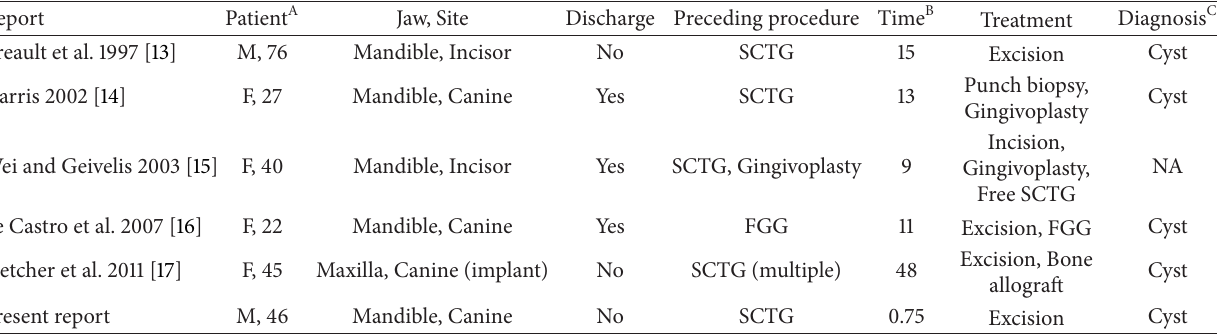
Figure 4: Routine histology of lesion: low-power (a) and higher power (b) photomicrographs. Note the stratified squamous nonkeratinized cystic epithelium lining the lesion and the surrounding subacutely inflamed fibrous connective tissue (hematoxylin and eosin, original magnification: (a) × 40; (b) × 100). Table 1: Cyst and cyst-like lesions as sequelae of soft tissue